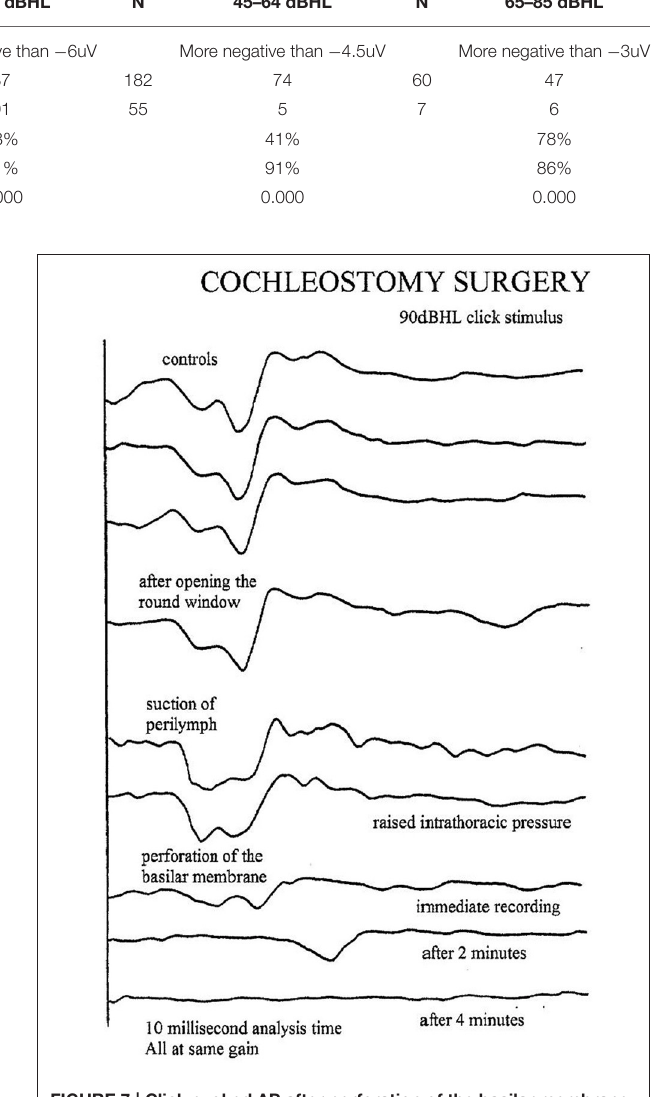
FIGURE 7 | Click evoked AP after perforation of the basilar membrane (Schuknecht’s cochleostomy Procedure; Schuknect,